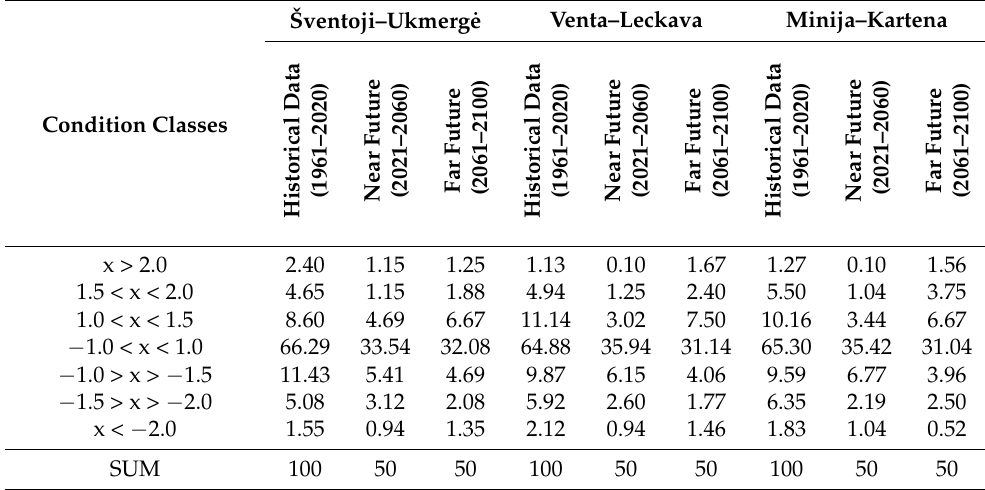
Table 6. Changes of SPI (x in Table) according to RCP 8.5.